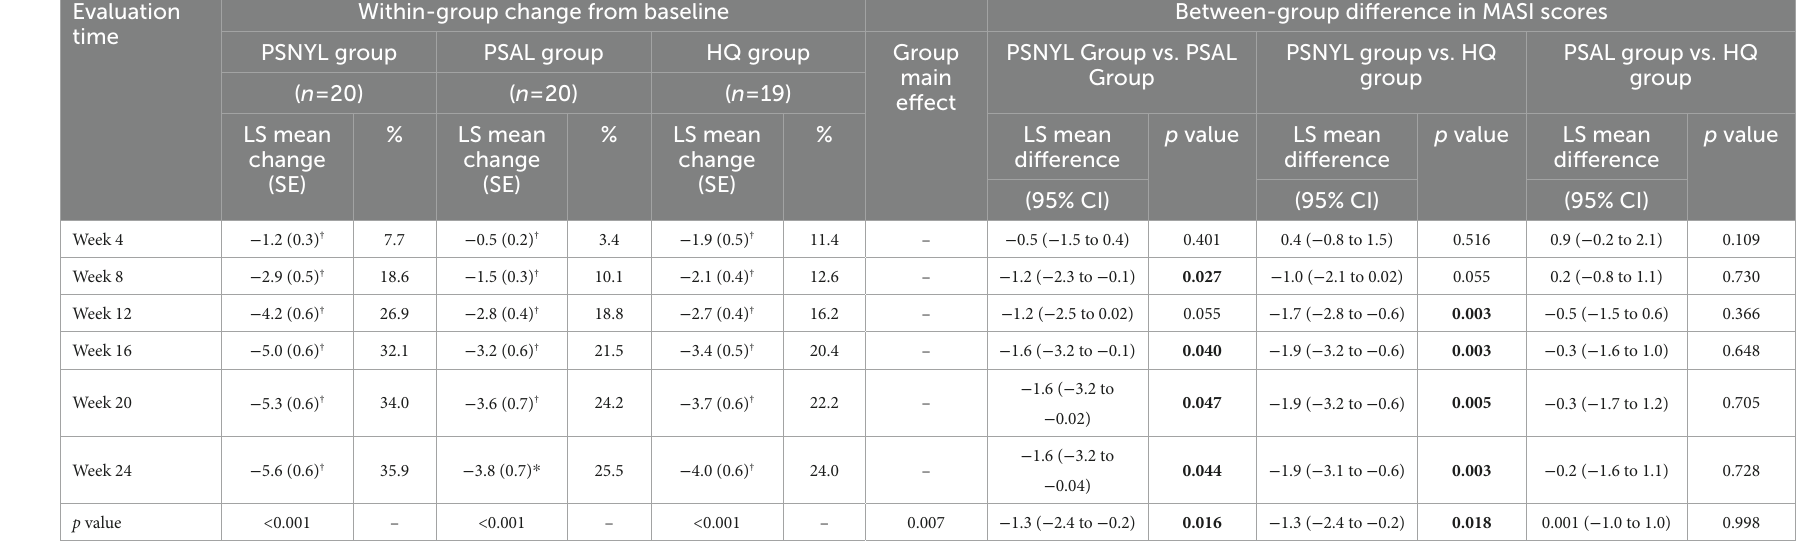
Within-group change from